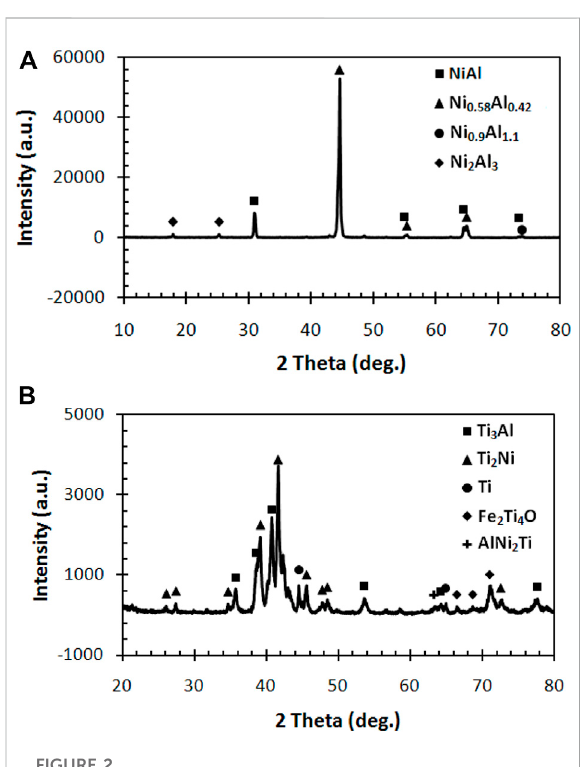
FIGURE 2 XRD spectra identi fi ed at (A) coating, and (B)